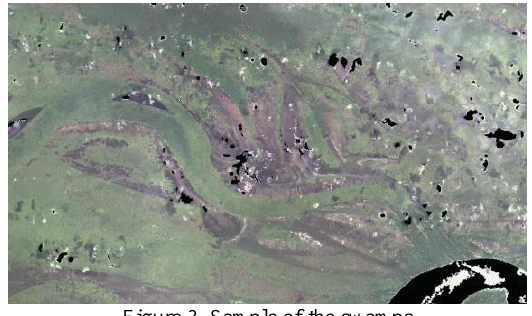
Figure 3. Sample of the swamps